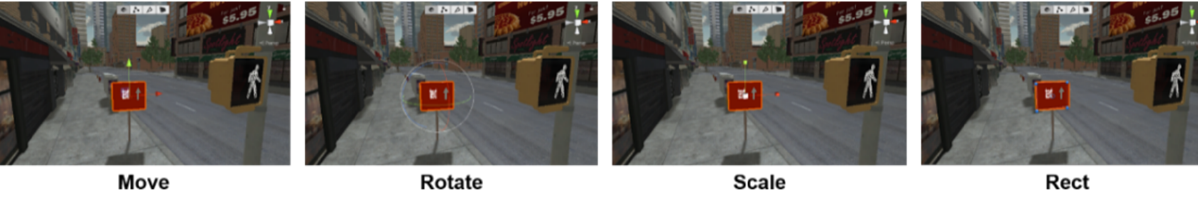
Figure 3. Interface outline of our urban design tool, which is based on Unity 3D and allows users to create 3D urban elements either from a half-made model ( D ) or from scratch ( E ) and fine-tune the design elements ( C ). Users can simulate the location, orientation, and size of the designed object ( A ) while checking a virtual pedestrian’s viewpoint or visual attention ( B ).